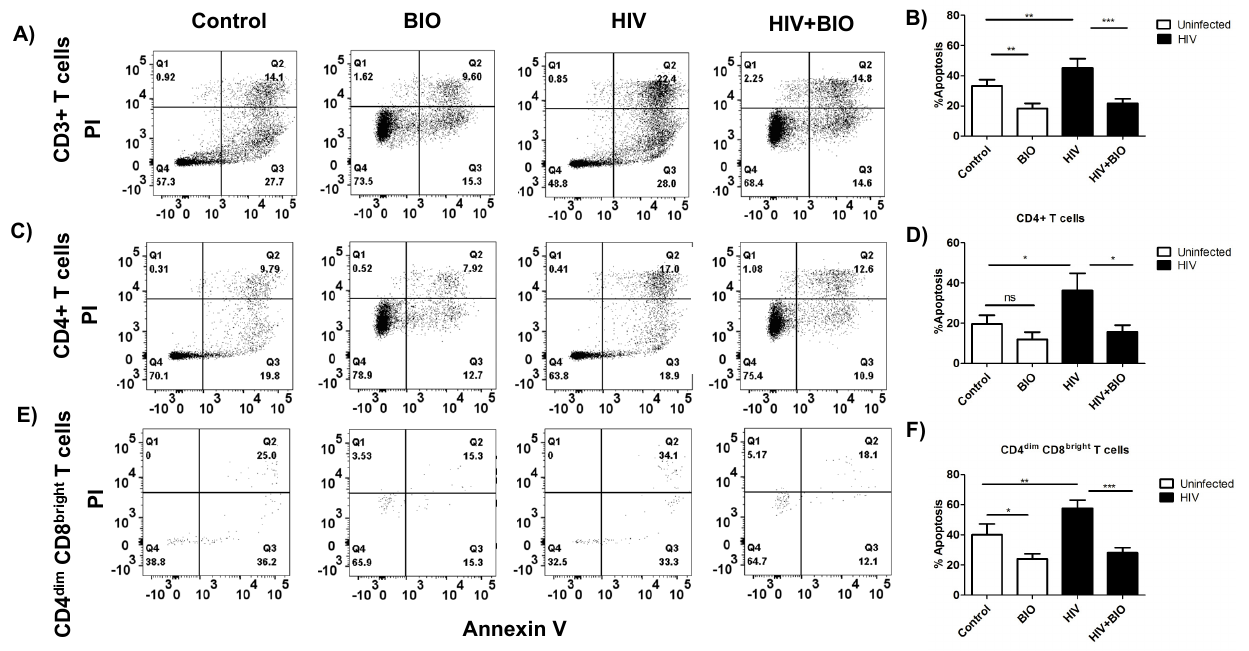
Figure 2. Induction of Wnt/ β -catenin signaling protects T cell subsets from HIV-mediated apoptosis. PBMCs were cultured in complete RPMI and activated for 3 days with anti-CD3/CD28 antibodies in the presence of 30 U/mL IL-2, then infected with HIV Bal , or left uninfected, for 6 h, washed, and 24 h. post infection cells were treated with BIO or DMSO. ( A , C , E ) Representative dot blots of day six post infection and treatment with BIO in CD3, CD4+, and CD4 dim CD8 bright T cell populations. Flow data were collected and analyzed. ( B , D , F ) Cumulative data of apoptosis percentage (early and late apoptosis) on day six post infection and treatment with BIO in CD3+, CD4+, and CD4 dim CD8 bright T cell populations. n = 4 per treatment. Data are represented as mean ± SEM and analyzed using one-way ANOVA and Newman–Keuls multiple comparisons test. * means p ≤ 0.05, ** p ≤ 0.01, *** p ≤ 0.001. ns denotes no significance.